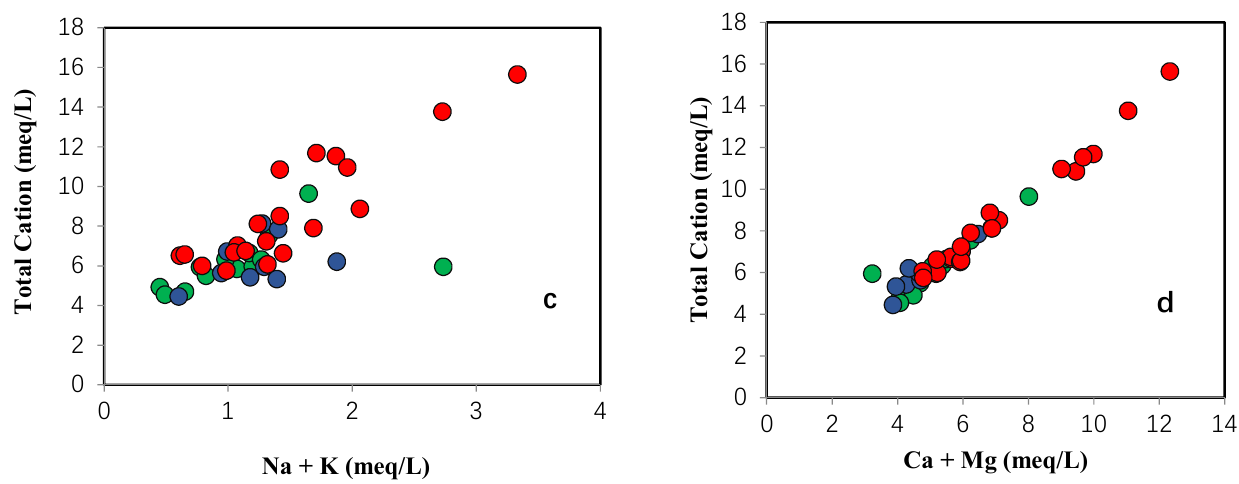
Figure 7. Bivariate plots of ( a ) Ca + Mg vs. HCO 3 + SO 4 , ( b ) Ca + Mg vs. HCO 3 , ( c ) Na + K vs. total cation and ( d ) Ca + Mg vs. total cation concentration in the groundwater samples.